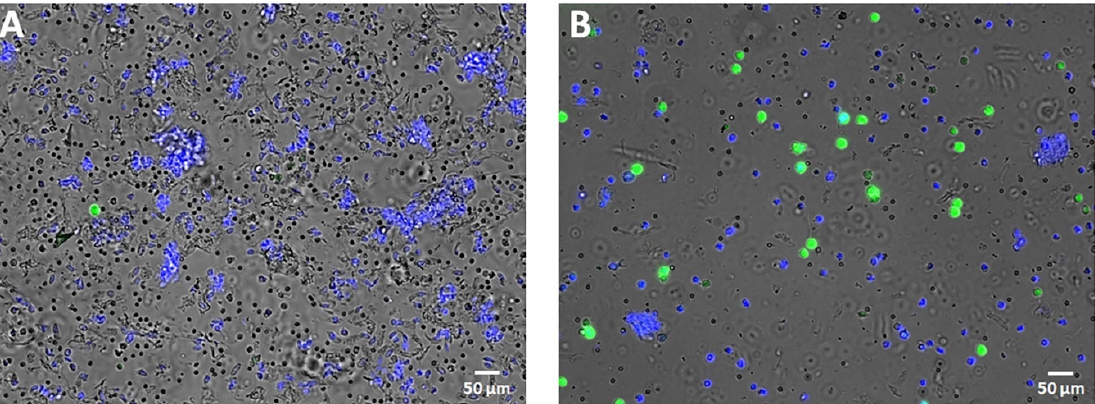
Figure 2. Representative images of cytological assessment of uterine cells stained with H 2 DCF-DA and H33342 and analyzed by fluorescence microscopy in endometritis negative ( A ) and positive ( B ) mares. Table 1. Mean ( ± SD) values of oxidative, inflammation, and protease regulator biomarkers assessed in the blood serum and the uterine fluid of mares with negative (n = 9) and positive (n = 24) outcomes for the diagnosis of endometritis based on microbiological